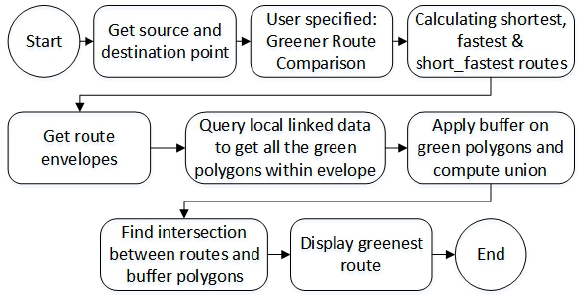
Figure 5. Greener route comparison flowchart